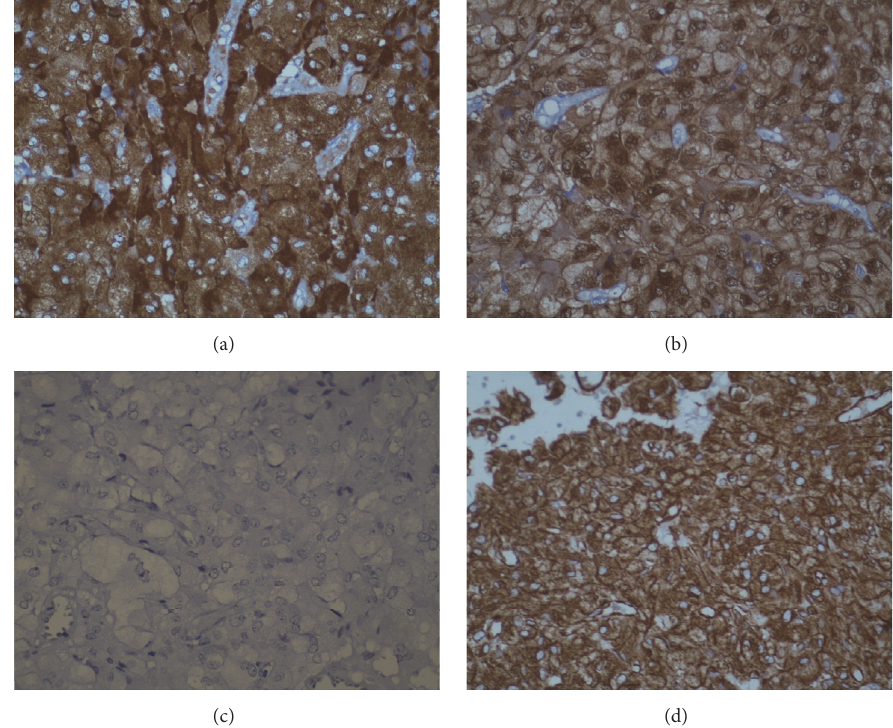
Figure 3: Immunohistochemical findings. (a) Tumor cells showing strong cytoplasmic immunoreactivity for chromogranin ( × 400). (b) Sustentacular cells showing strong nuclear and cytoplasmic immunoreactivity for S-100 ( × 400). (c) Tumor cells are nonimmunoreactive for Ki-67 ( × 400). (d) Tumor cells showing strong cytoplasmic immunoreactivity for vimentin ( ×